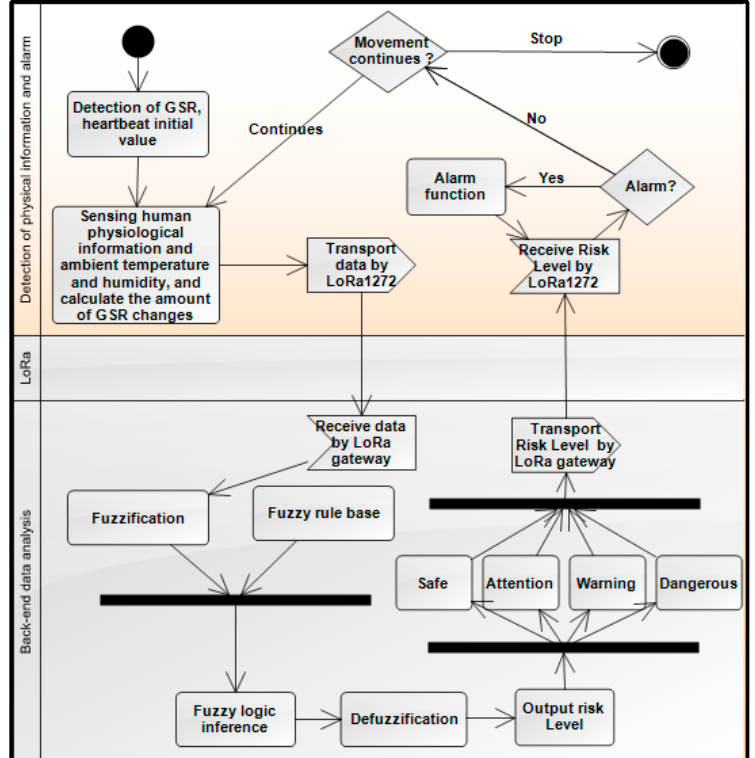
Figure 3. WHDD system algorithm.